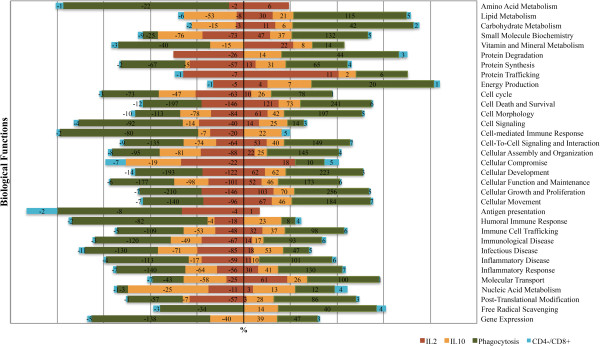
Biological functions significantly affected when comparing the high versus low groups forin vitroproduction of IL2, IL10, phagocytosis activity and CD4-/CD8+cell counts. Statistical significance of biological functions modulation was calculated via a right-tailed Fisher’s Exact test in Ingenuity Pathway and represented as –log (P value): -log values exceeding 1.30 were significant (FDR q-values < 0.05). For each pathway, the number of affected genes is indicated for each IT in the corresponding coloured box. The numbers of genes that were down-expressed (negative numbers) or up-expressed (positive numbers) in the high group are on the left and right sides of the graph, respectively.